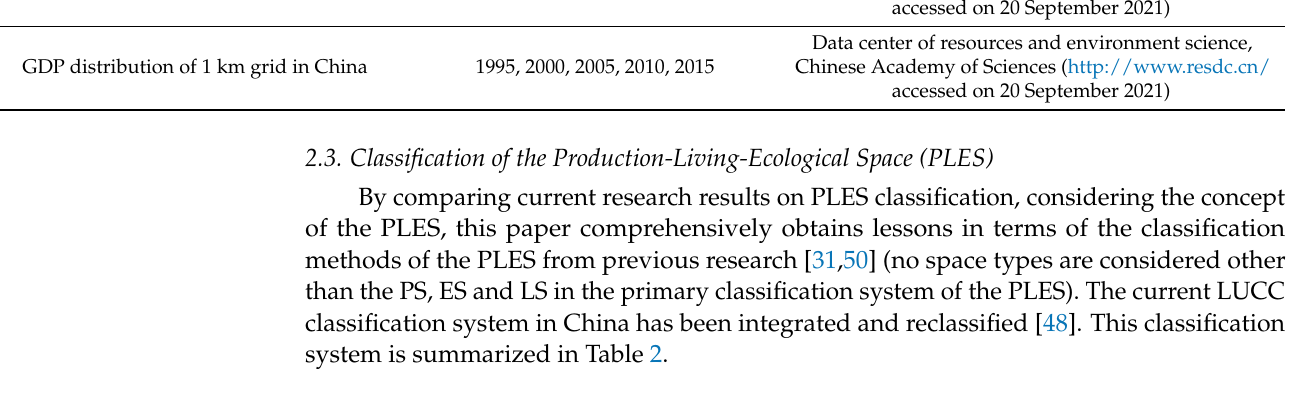
Table 2. Classification system of production-living-ecological space (PLES) of urban agglomeration in the middle reaches of the Yangtze